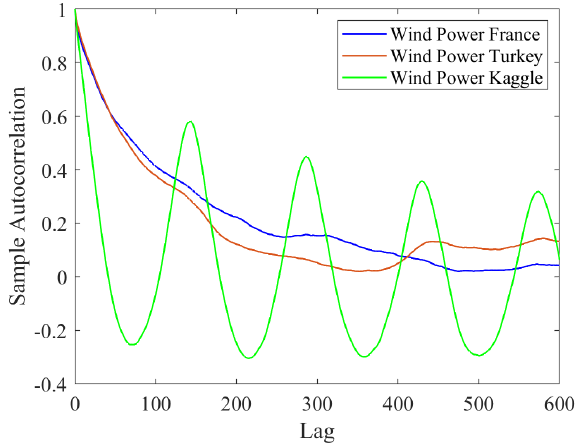
Figure 7. ACF of wind power time-series data.